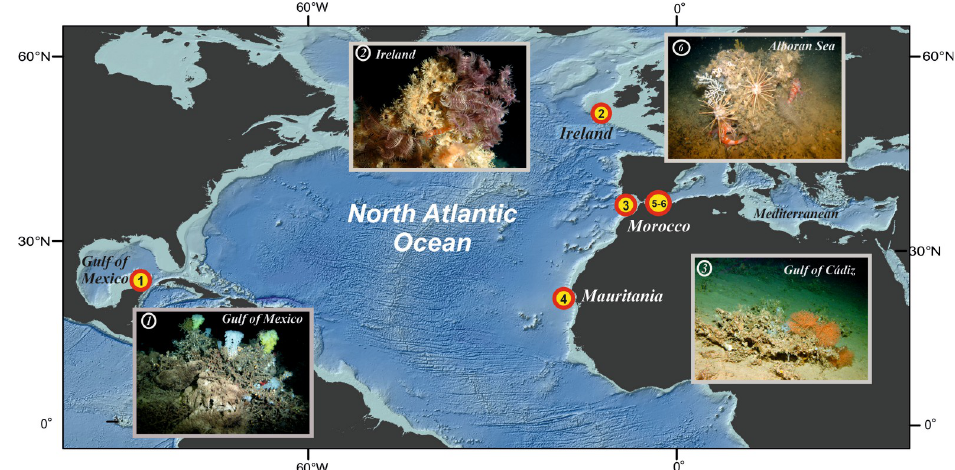
Fig 1. Distribution of case study sites in the North Atlantic Ocean and in the Mediterranean Sea. North Atlantic: ( 1 ) Gulf of Mexico (Campeche Bank), ( 2 ) Irish margin (Porcupine Seabight), ( 3 ) Moroccan margin (Gulf of Ca´diz), ( 4 ) Mauritanian margin; Mediterranean: ( 5 ) Alboran Sea (West Melilla) and ( 6 ) Alboran Sea (East Melilla). Map was produced with ESRI ArcGIS 10.7; Source of bathymetry: GEBCO 2019 Grid [59]. ROV images copyright MARUM ROV Cherokee , Bremen , Germany